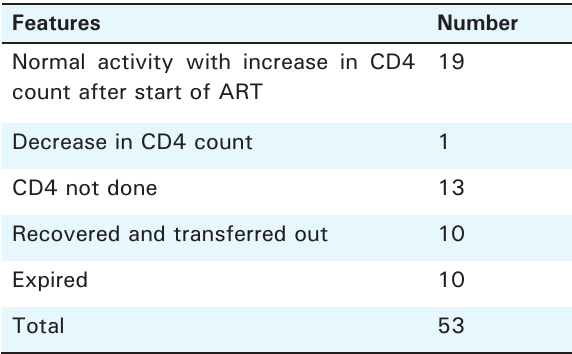
table 4. Performance of the patients undertaking ARt